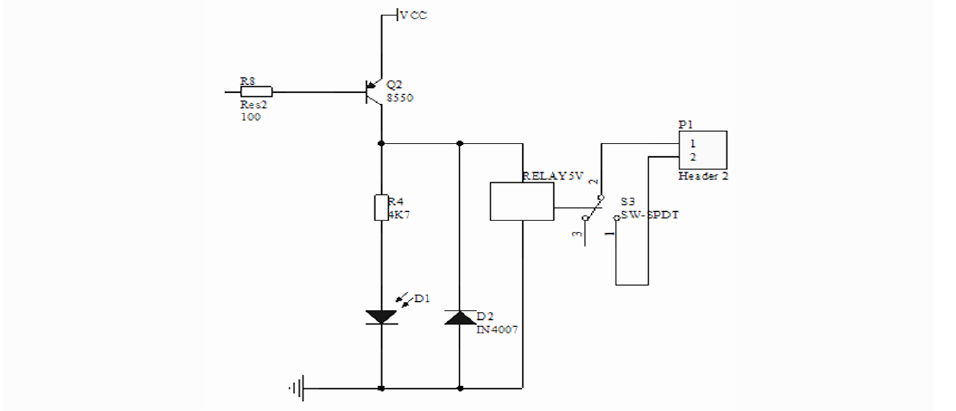
Figure 2. CC2530 Application